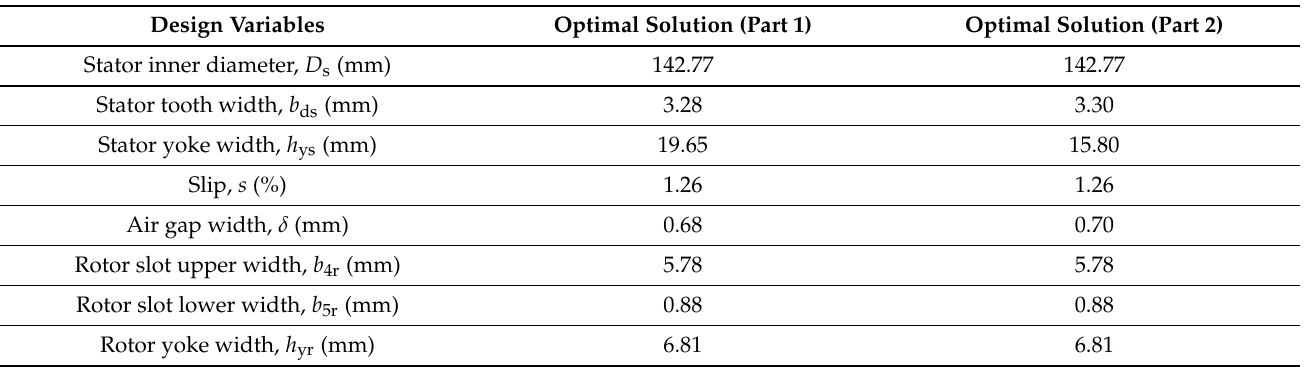
Table 13. Comparison of design variables of the optimal solution (part 1—surrogate optimization vs. part 2—pattern search) from the the proposed surrogate optimization routine–multivariate optimization problem.